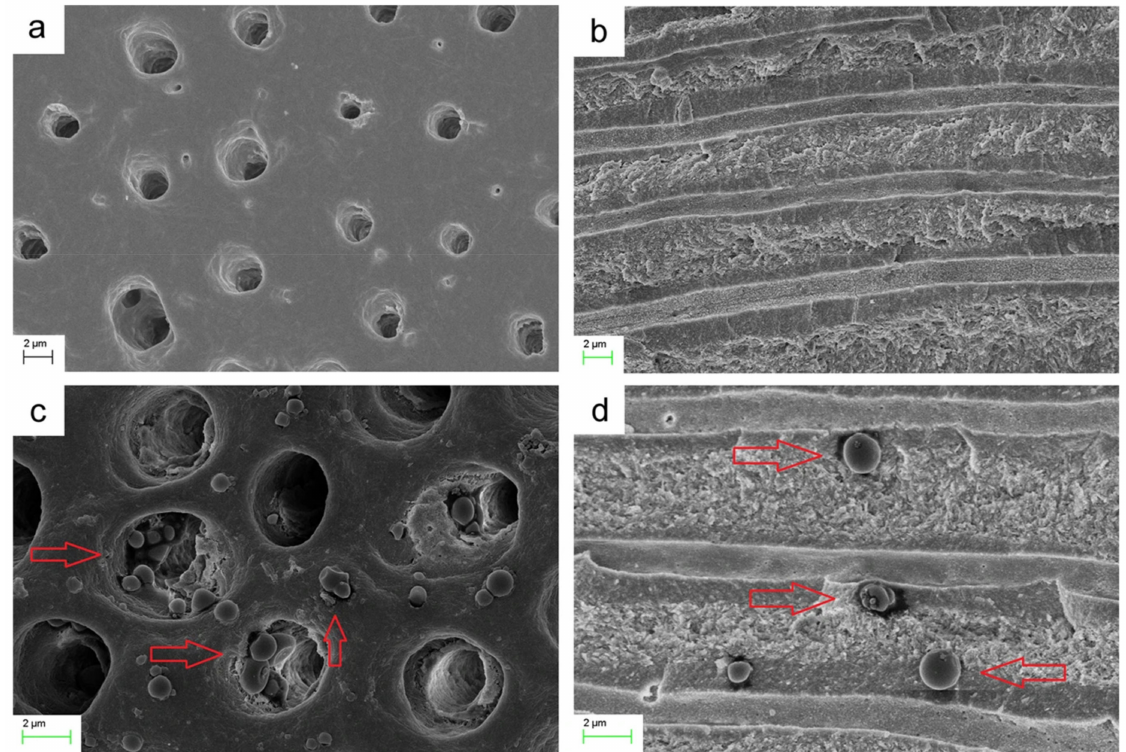
Figure 5. Infiltration of PLGA NPs loaded with CHX, calcium, and phosphorous into dentinal tubules. ( a ) Original dentinal tubule orifices; ( b ) original axial cross-section of dentinal tubules; ( c ) dentinal tubule orifices after NPs medication; ( d ) axial cross-sections of dentinal tubules after NPs medication. Red arrows indicate the NPs. Reproduced with permission from Fan et al.